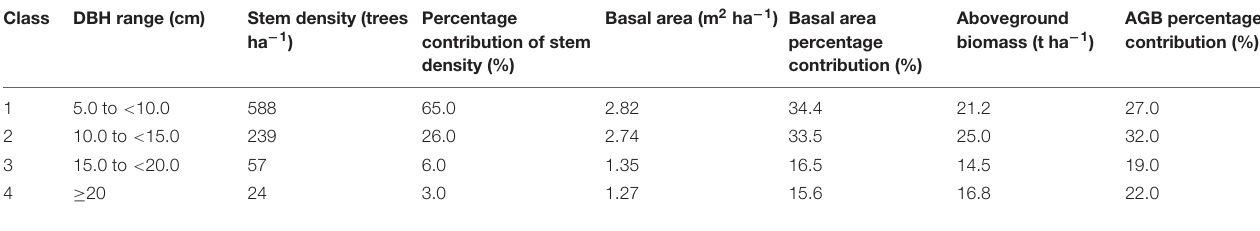
TABLE 1 | Proportional contribution of different diameter at breast height (DBH) size classes to stem density, basal area and aboveground biomass (AGB) of the study region. Class DBH range